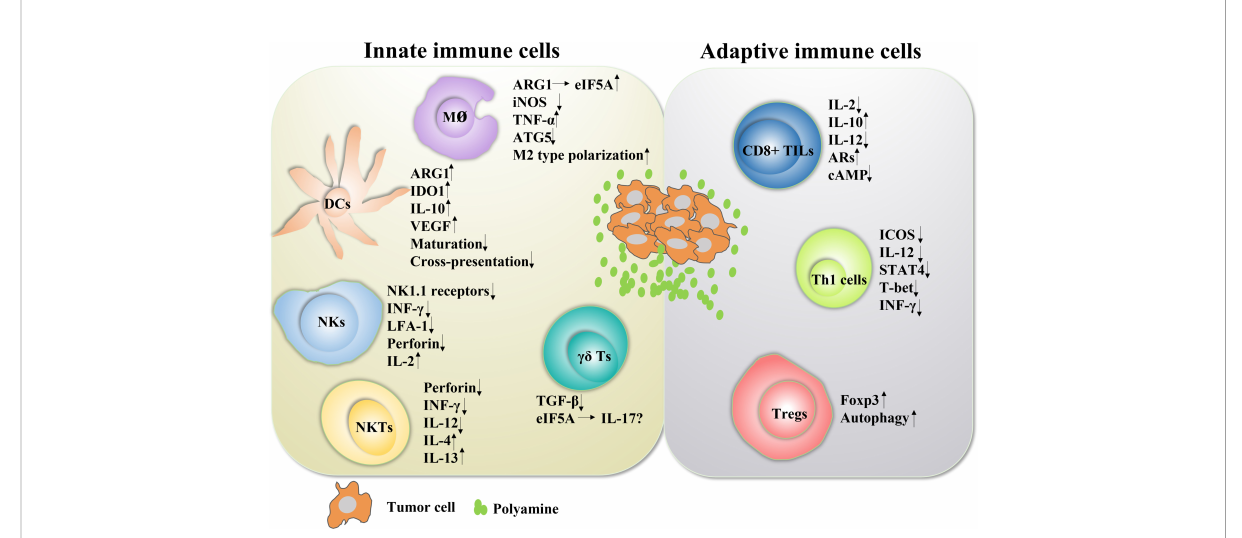
FIGURE 3 The role of polyamines in both innate and adaptive immune responses in cancer Polyamines and their key enzymes can reshape the tumor immune microenvironment through a variety of transcription factors or cytokines, even have dual roles. The polyamine-eIF5A- hypusine axis regulates macrophage polarization, especially polyamines tend to promote the polarization of M2-type macrophages. Polyamines also negatively regulated the functions of DC cells, NKT cells, CD8+ TILs and Th1 cells, and positively regulated the functions of Treg cells. For NK cells, polyamines are a double-edged sword. In fact, the tumor immune microenvironment is mutually in fl uenced and restricted by a variety of factors. The regulation of polyamines in regulating the function of immune cells is not absolute, which will change according to the changes of tumor immune